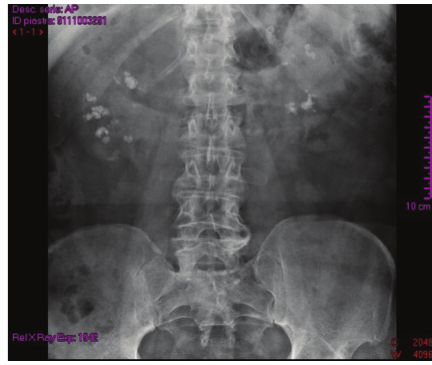
Figure 2: Appearance on “bouquet of flowers.”